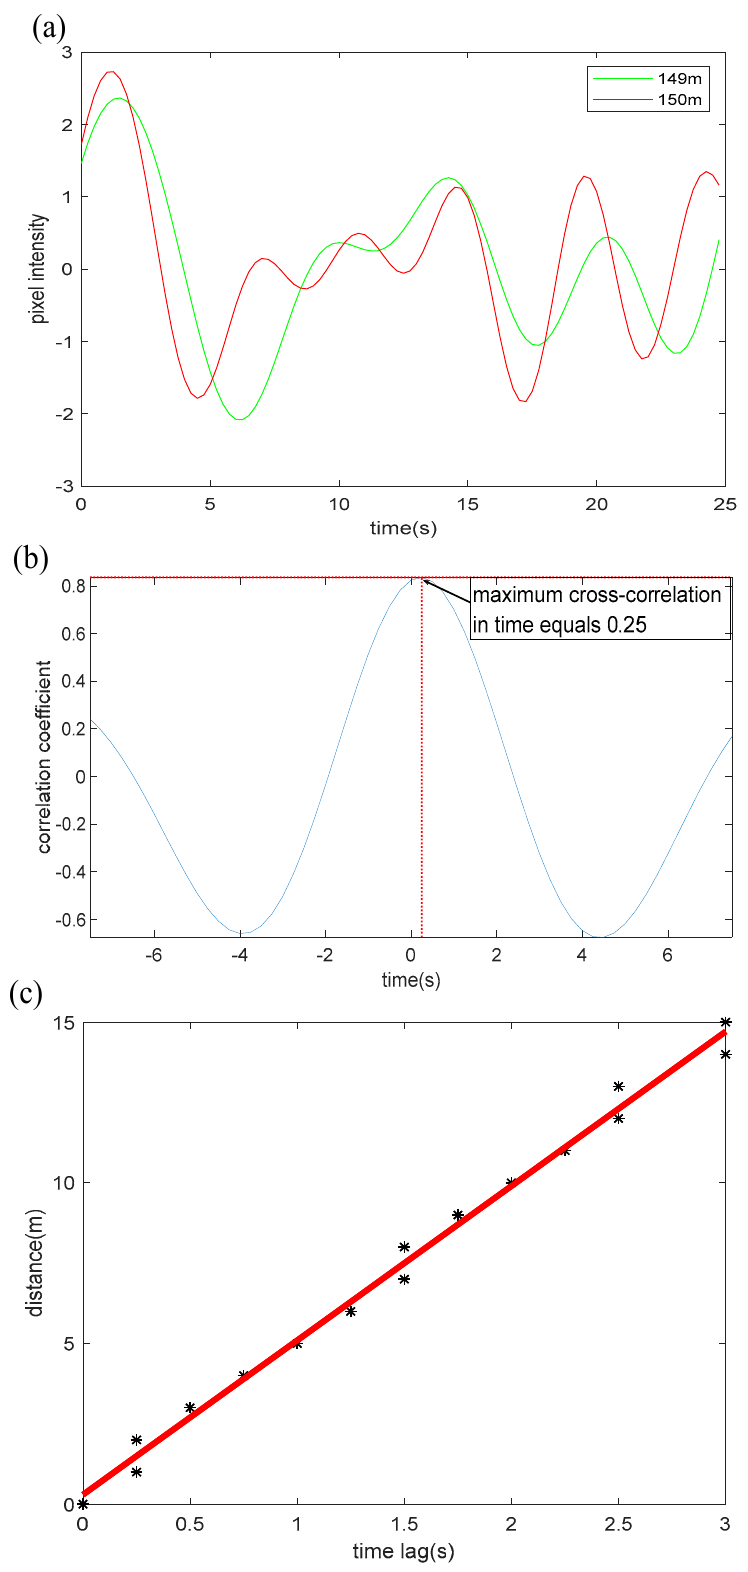
Figure 13. Wave celerity estimation. ( a ) The pixel fluctuation of adjacent pixels shows a specific correlation. ( b ) Maximum cross-correlation determines the propagation time of the wave. ( c ) The propagation time and distance between each pixel and the reference pixel in the suitable estimation range are determined and carried out the linear fitting method.